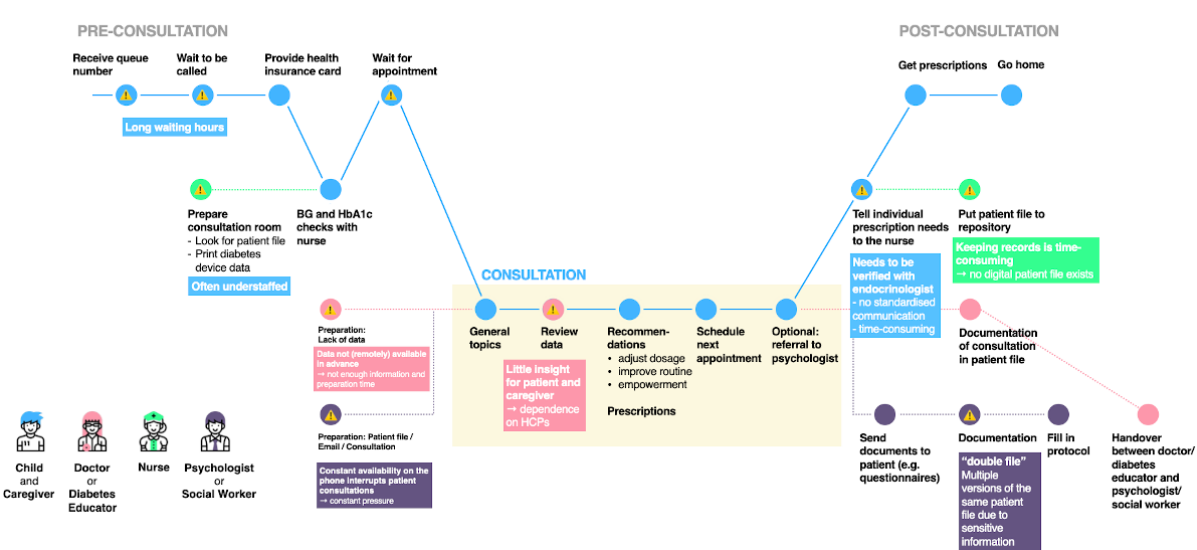
Figure 2. The "as-is" patient journey, the workflow of a conventional clinic visit, and current problem areas that require improvements. HbA 1c : hemoglobin A 1c ; HCP: health care professional; BG: blood glucose.